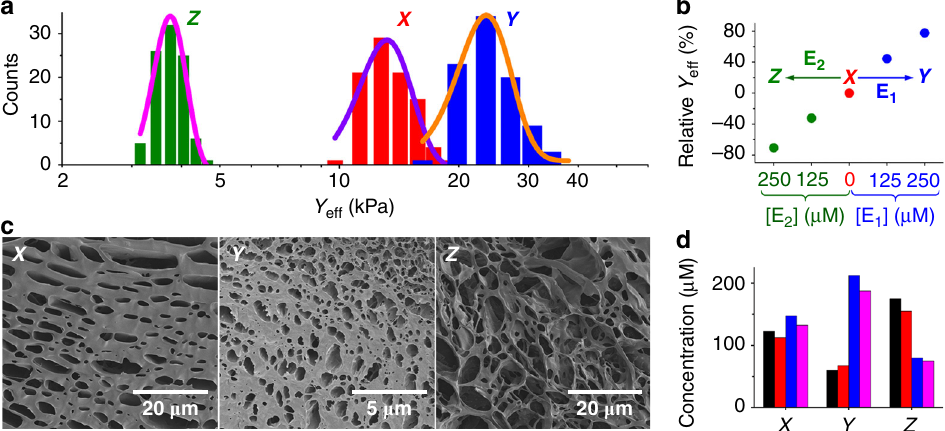
Fig. 2 Controlling the stiffness properties of hydrogels consisting of triggered constitutional dynamic networks. a Histograms and corresponding Gaussian fi ts of Young ’ s moduli associated with CDN hydrogels X, Y, and Z. b Young ’ s modulus changes of hydrogel X programmed by the concentrations of effector E 1 or E 2 . Relative Y eff = ( Y eff − Y eff(X) )/ Y eff(X) × 100%, where Y eff(X) represents Young ’ s modulus of hydrogel X without any triggers. c Scanning electron microscopy images of CDN hydrogels X, Y, and Z. d The concentrations of the constituents AA ’ , BB ’ , AB ’ , and BA ’ in CDNs X, Y, and Z Table 1 Quantitative assessment of the compositions of the CDNs System